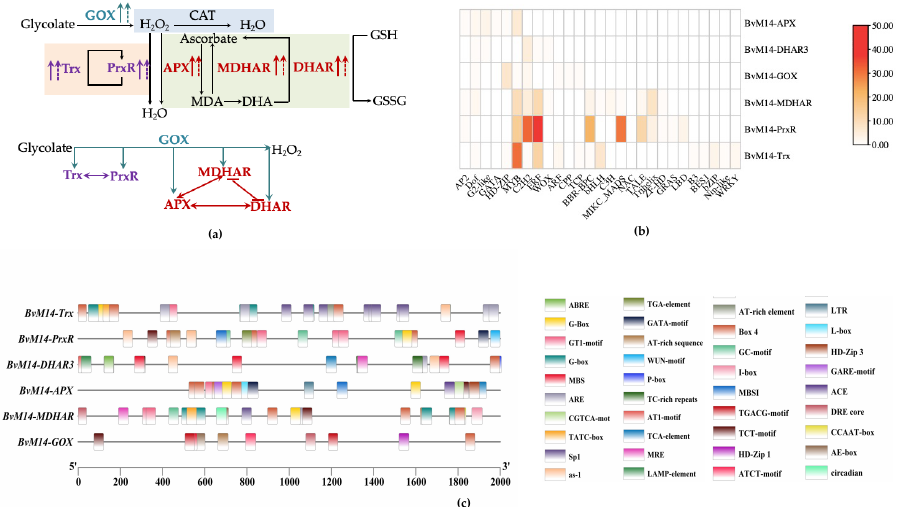
Figure 8. Regulatory networks of the six antioxidant enzymes in the Bv M14: ( a ) The role of BvM14- GOX , BvM14-PrxR , BvM14-Trx , BvM14-APX , BvM14-DHAR3 , and BvM14-MDHAR gene in antioxi- dant enzyme system; ( b ) the TF binding motifs in the promoter regions of BvM14-GOX , BvM14-PrxR , BvM14-Trx , BvM14-APX , BvM14-DHAR3 , and BvM14-MDHAR ; ( c ) localization of the more frequent cis -acting elements among the BvM14-GOX , BvM14-PrxR , BvM14-Trx , BvM14-APX , BvM14-DHAR3 , and BvM14-MDHAR in the promoter regions. The cis -regulatory elements presented are labled with different colors and illustrated on the right side. The TATA-box and CAAT-box are not shown. (The dashed line indicates the transcript level and the solid line indicates the activity level; the arrows indicates positive; the lines indicates